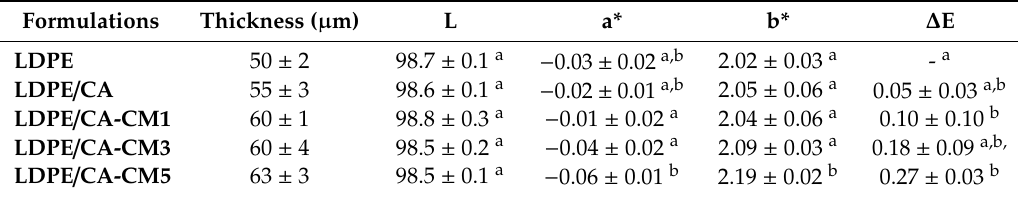
Figure 3. UV-vis spectra of LDPE and LDPE / CA-coated films. Table 2. Color properties of CA-CM-coated LDPE films.